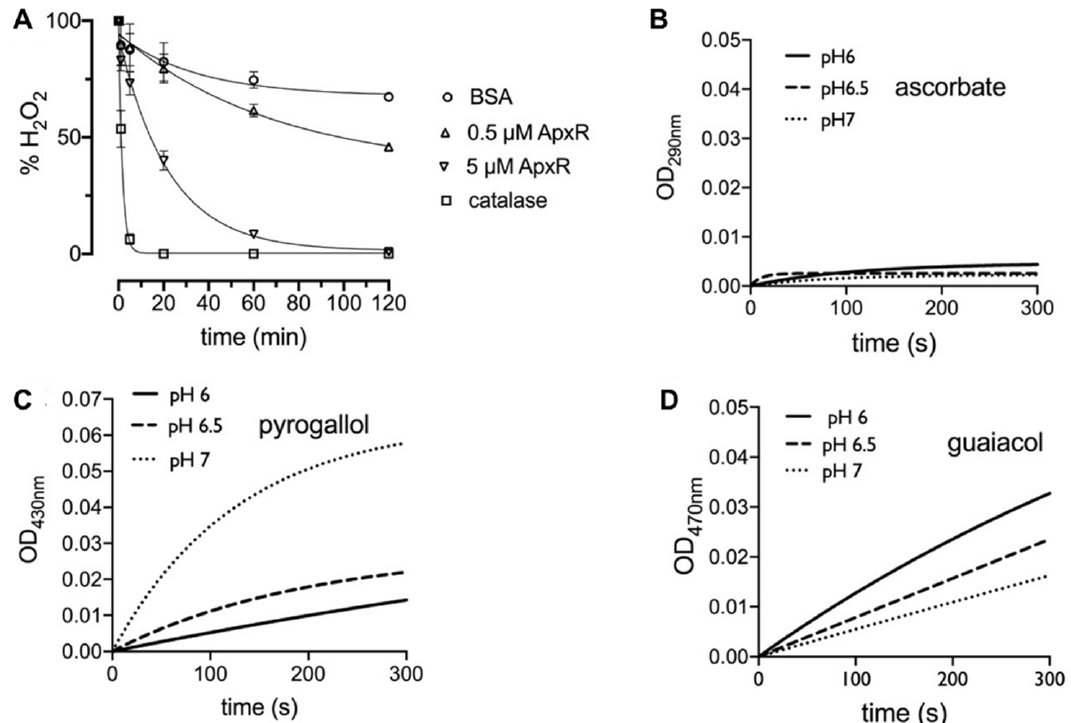
Figure 1. APx-R displays heme peroxidase activity. ( A ) FOX assay showing H 2 O 2 reduction rate in the presence of BSA (negative control), APx-R at 0.5 and 5 µ M, and catalase (positive control); and (B–D) the oxidation of the electron donors L-ascorbic acid ( B ), pyrogallol (1 µ M) ( C ), and guaiacol (0.2 µ M) ( D ) mediated by APx-R (1 µ M) was analyzed at pH 6, 6.5,